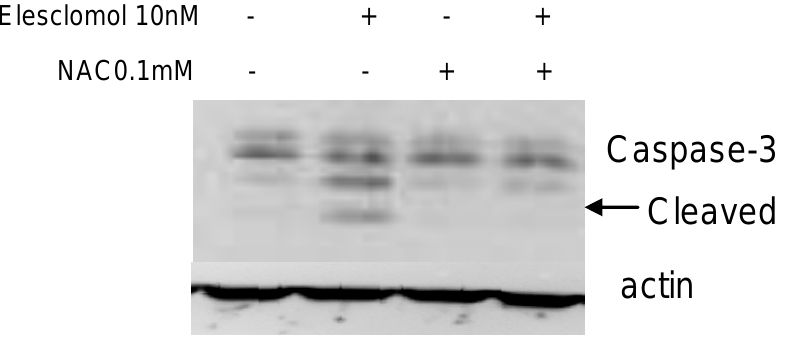
Figure 8. Immunoblot analysis of cleaved caspase-3 on SCLCSR2. Treatment with 10 nM of elesclomol for 72 h induced caspase 3 cleavages (arrow) which can be reversed with cotreatment of 0.1 mM of NAC (72